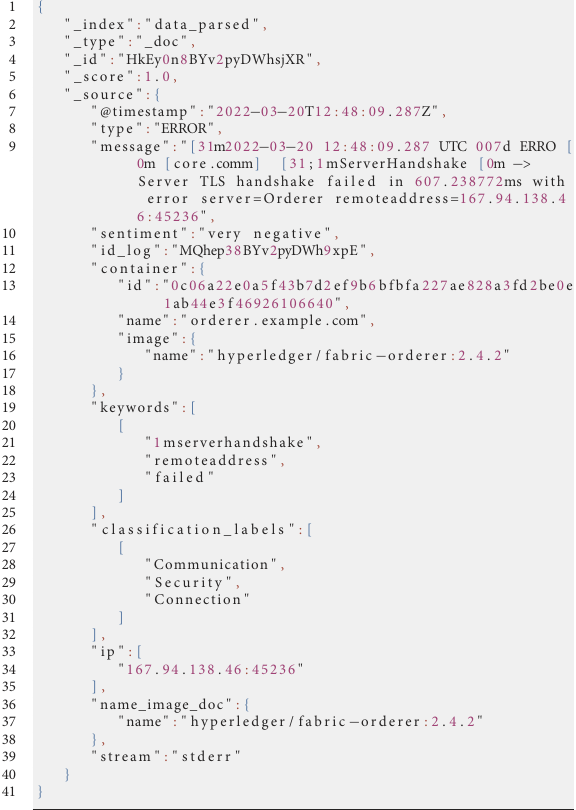
Listing 1 Simplified structure of processed logs used on Hyperledger Fabric